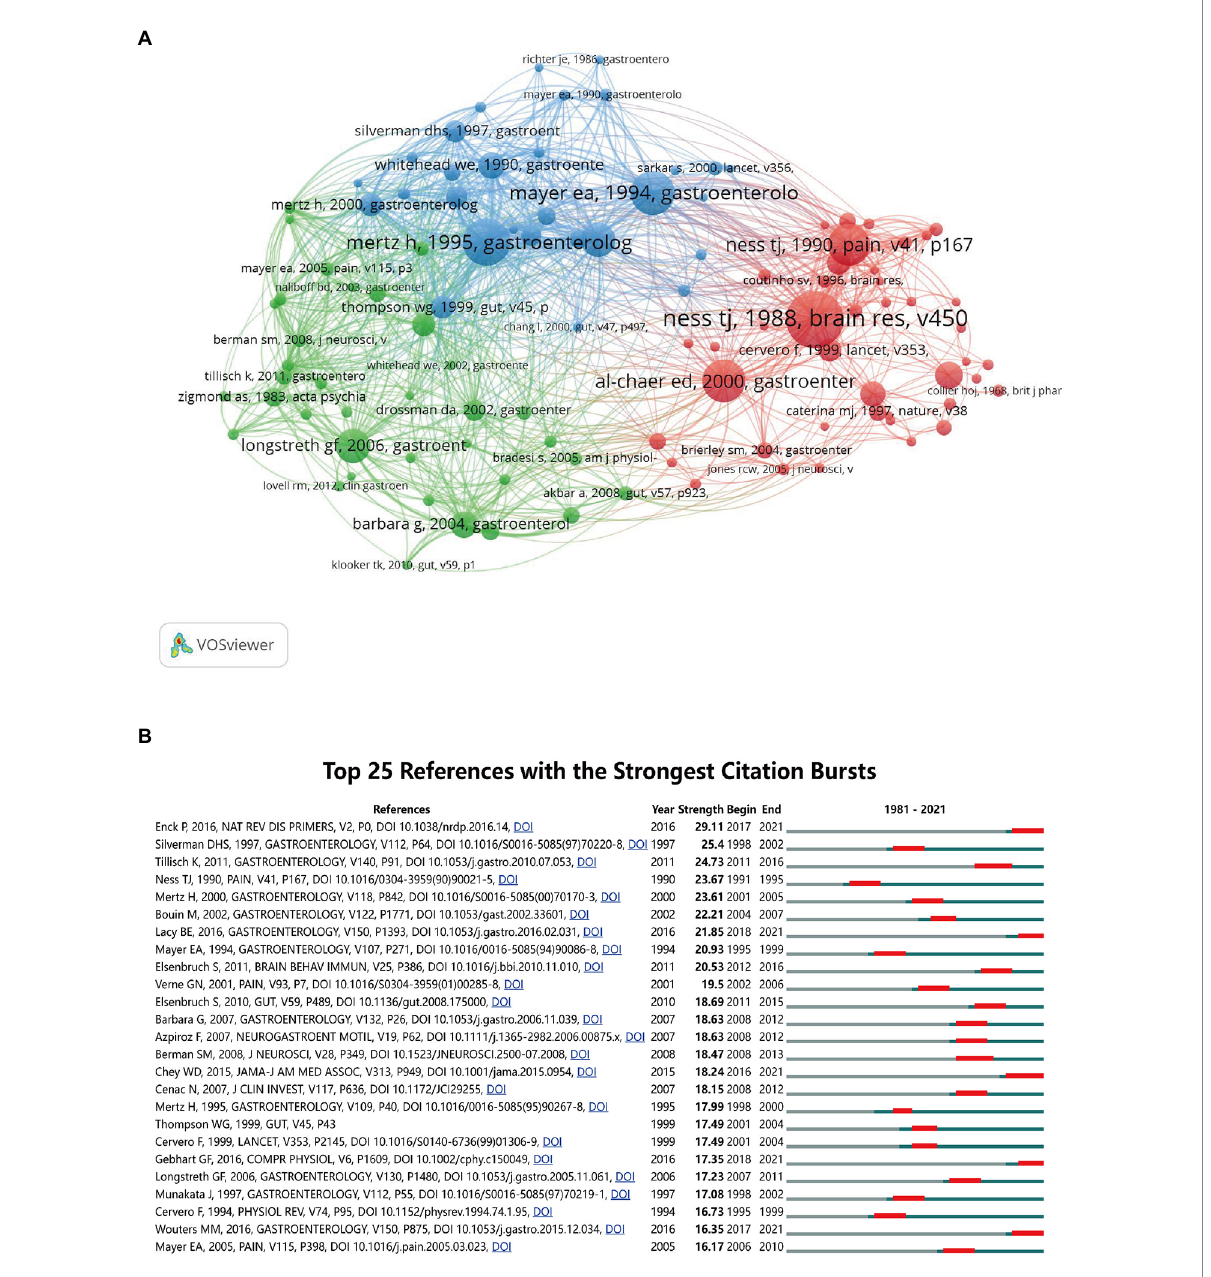
related to visceral pain, with the top 5 keywords being visceral pain hypersensitivity (214 times), and inflammation (133